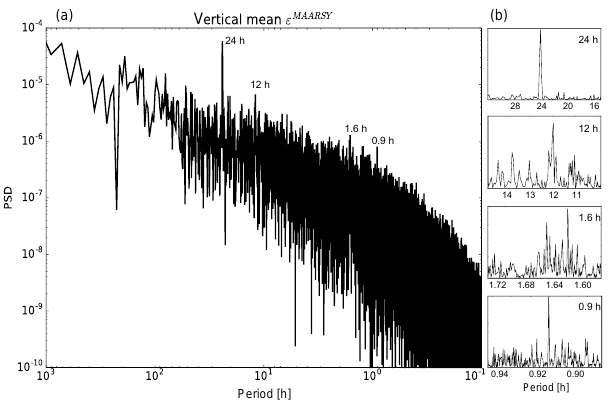
Figure 18. Left: power spectral density derived by applying fast Fourier transform to a time series of vertical means between 80 and 90km of MAARSY turbulence measurements during PMSE season 2013, i.e. 1 May to 31 August. Right column: zoom in on selected periods marked on the left panel. Note linear scales for both axes.